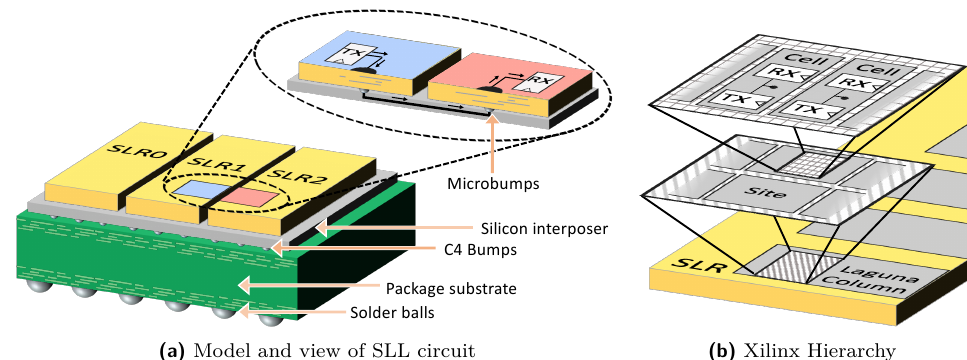
Figure 1: Xilinx multi-chiplet system. (a) shows the physical representation of the chiplet- based system, with an expanded view of the path of a single SLL through the interposer, the delay of which is used as an entropy source. (b) shows the hierarchy of the Xilinx architectural primitives for communicating between SLRs that are used in this